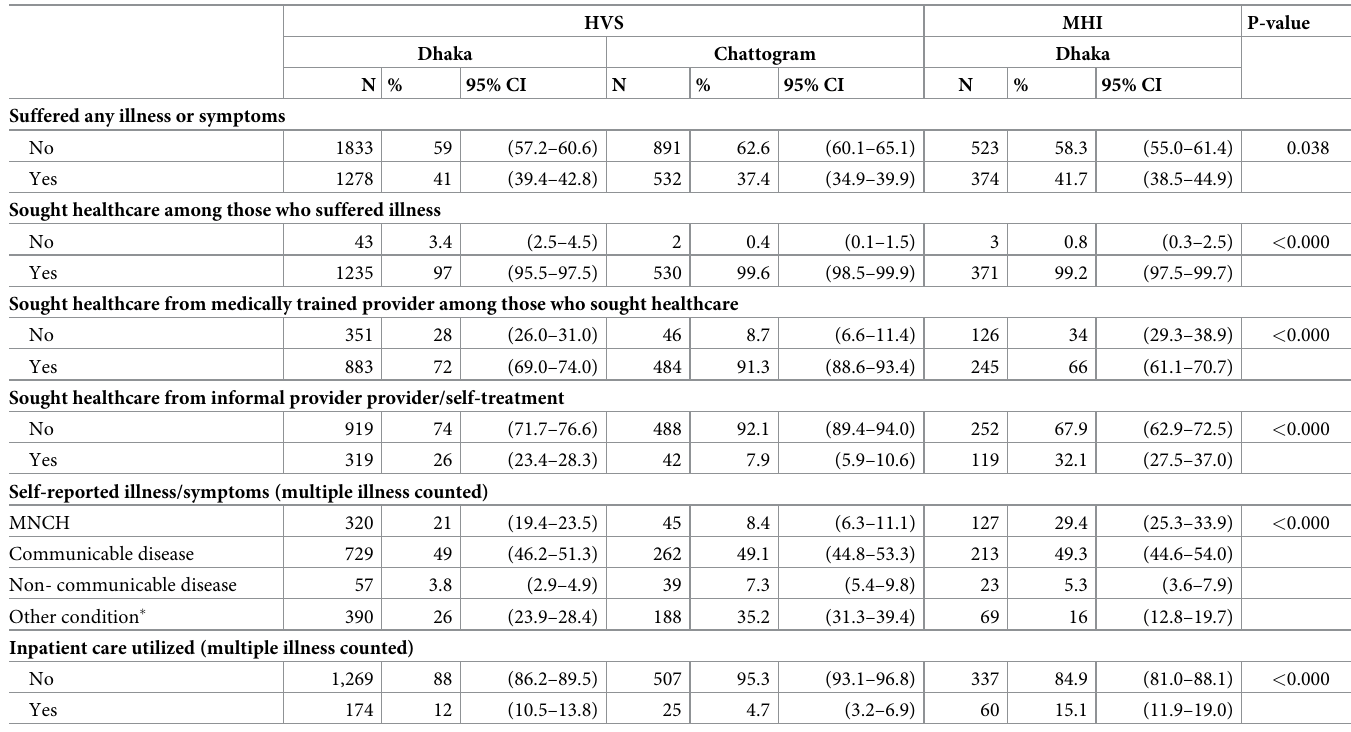
Table 5. Pattern of healthcare utilization by type of scheme.